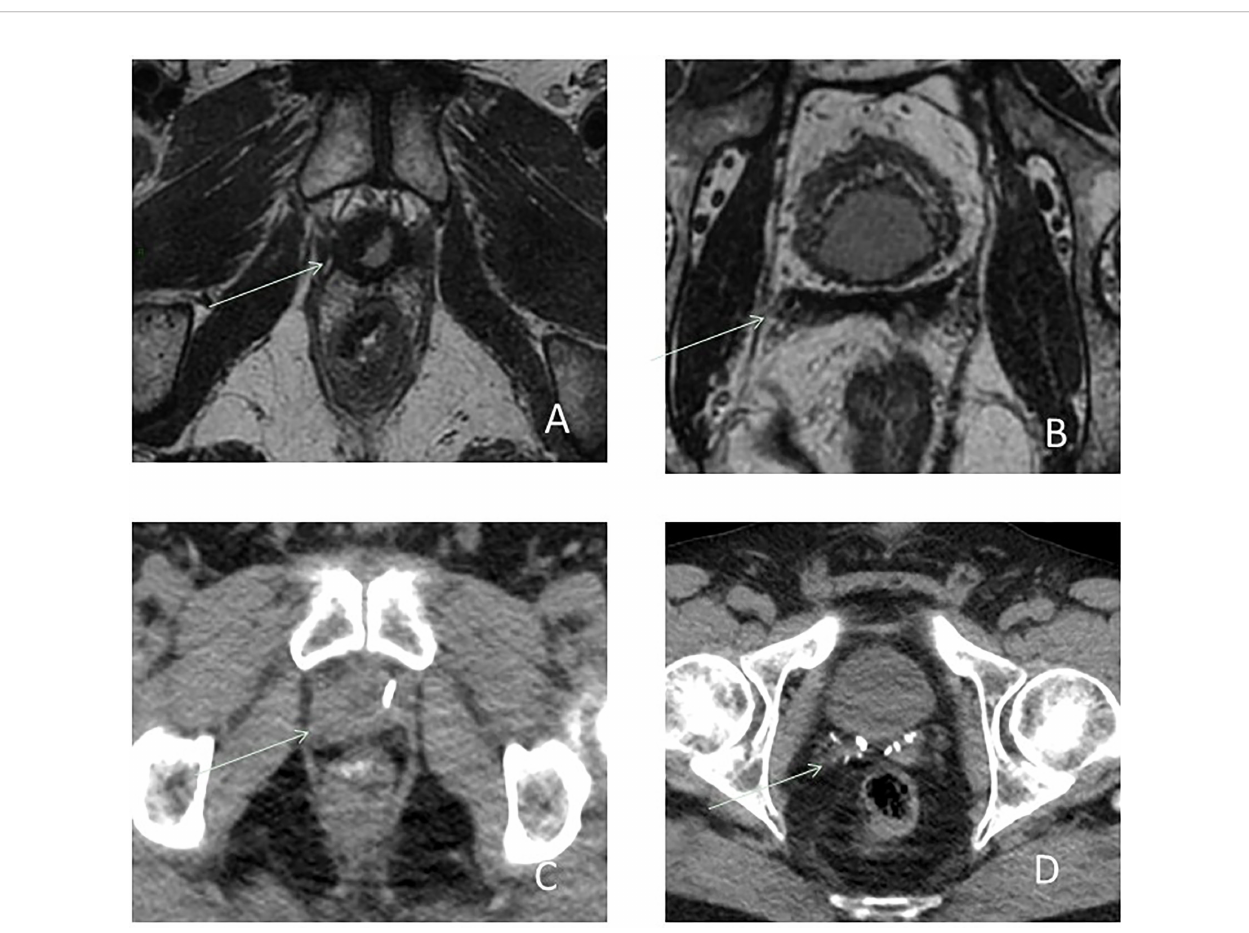
FIGURE 5 | Biological recurrence in a 58-year-old male. Axial T2-weighted images (A, B) and CT (C, D) showing the bene fi t of MRI to enable a better delineation of anatomical analysis of the VUA (A , C) , cut end of the vas deferens and SV bed (B , D) , and bladder neck, all common sites of